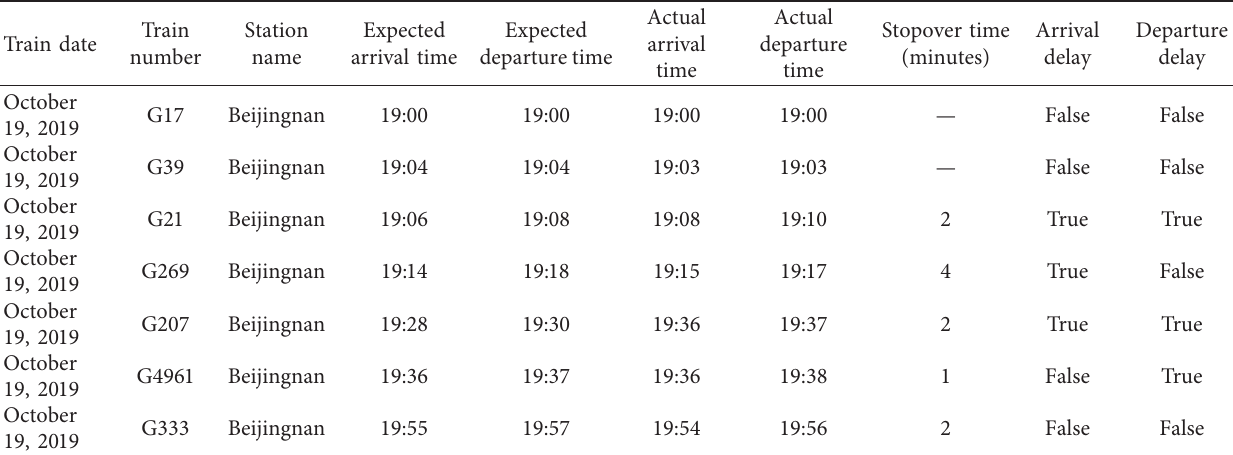
Table 2: China railway ticketing system train operation data.